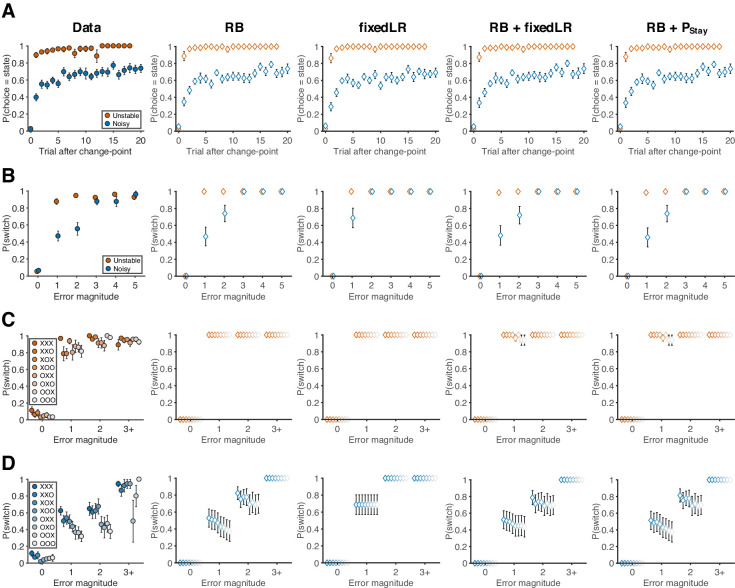
Behavioral data and predictions from different models.(A) Probability of choosing the best target after change-points. (RB: reduced Bayesian; fixedLR: fixed learning rate; Pstay: fixed tendency to stay) (B) The relationship between error magnitude and switch probability. (C) Probability of switch as a function of current error magnitude and error history in the unstable condition. (D) Probability of switch as a function of current error magnitude and error history in the noisy condition. Symbols and colors are as in Figure 2.